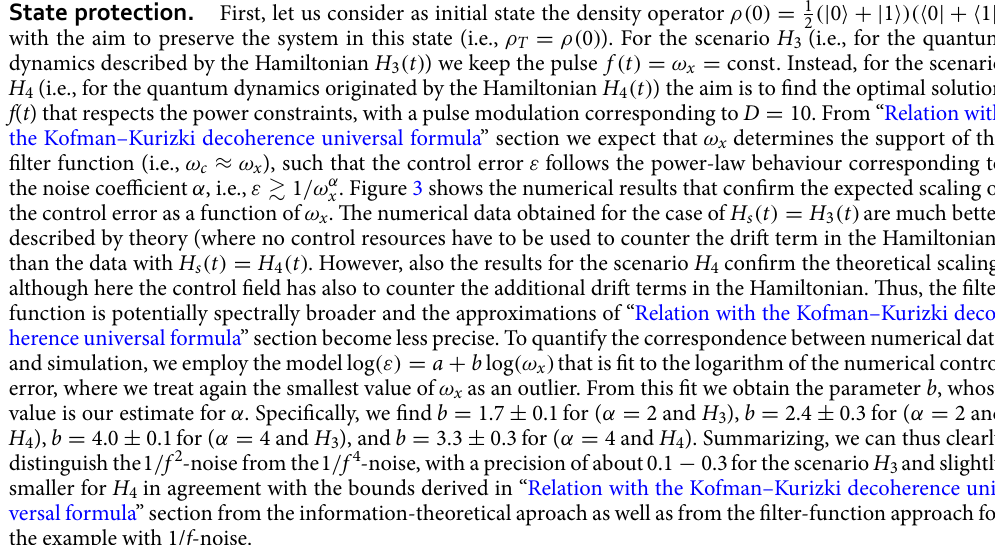
0, 1 ). Then, we fit the remaining data ∈ [ ] 0.51 , b 1 0.039 = =